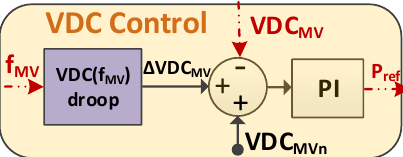
Figure 15. VDC ( f MV ) droop controller in the controller of the MV inverter (shown in Figure